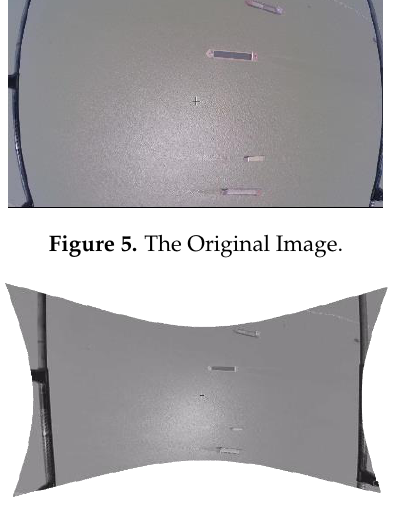
Figure 8. The vessel information extraction.